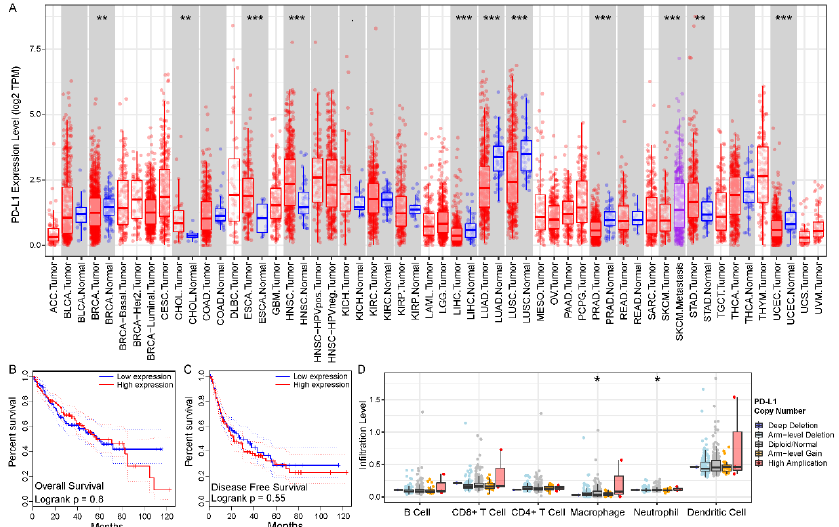
Figure 1. Abnormal patterns in expression, prognosis, and immune of PD-L1 in HCC. ( A ) Differ- ent expression levels of PD-L1 in various cancer types using TIMER. ( B , C ) The Kaplan-Meier survival curves showed the prognosis value of PD-L1 in overall survival and disease-free survival using GEPIA, respectively. ( D ) The differential infiltration levels of immune cells in different PD-L1 gene copy number variant types using TIMER. The asterisk character represent the statistical significance of difference, * p < 0.05; ** p < 0.01; *** p < 0.001. Biomolecules 2022 , 12 , x FOR PEER REVIEW